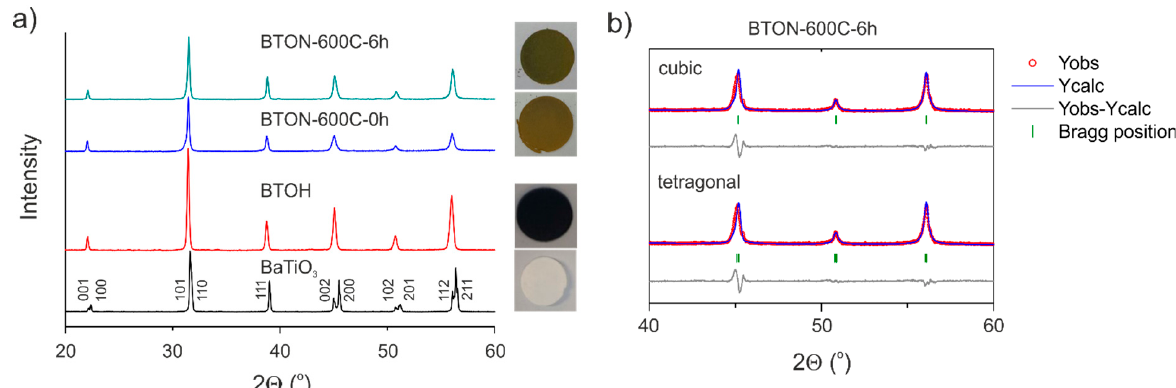
Figure 5. ( a ) PXRD patterns of BaTiO 3 employed for hydride reduction, BTOH, BTON-600C-0 h, and BTON-600C-6 h, with pictures on the right illustrating the sample colors. ( b ) Section of Rietveld plots for the PXRD pattern of BTON-600C-6 h when fitting a cubic structure ( a = 4.0111(2), 𝜒 2 = 4.90, R Bragg = 4.71, R F = 3.25) and tetragonal structure ( a = 4.0085(3), c = 4.0184(2), 𝜒 2 = 4.25, R Bragg = 5.45, R F = 3.66).